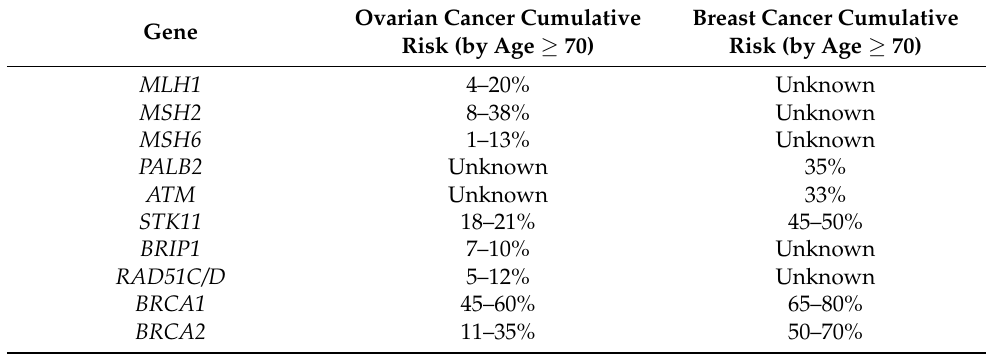
Table 1. Hereditary genomic mutation risk rates for developing breast and/or ovarian cancer.